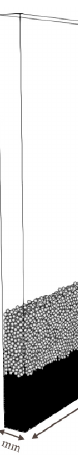
Figure 1. Schematic of the binary BFB with small and large particles.